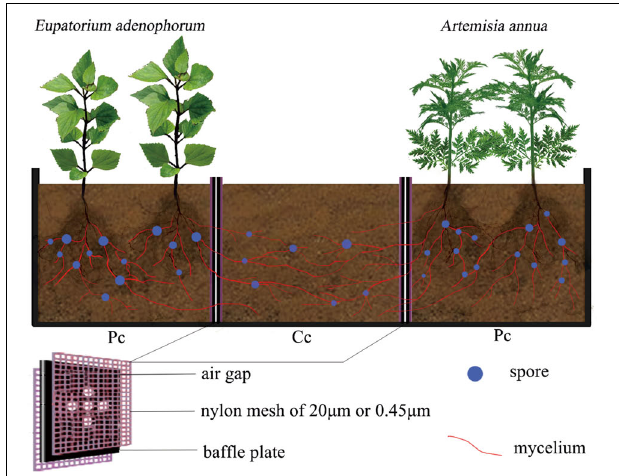
FIGURE 1 | The compartmentalized microcosm growing device. The setup consists of three compartments, two plant compartments on either end, one for the native species and one for the invasive species, and one competition compartment in the center. Plates containing five holes separate the compartments. Depending on the experimental treatment, one of two different meshes line the plates separating the plant compartments from the competition compartment. 20 µ m nylon mesh allows mycelium to pass through but not the plant root system; the 0.45 µ m nylon mesh blocks both mycelium and the plant root system from passing through the baffle plates into the competition compartment. An air gap within the baffle plate, described in more detail in the text, prevents the flow of nutrients between the three compartments. E. adenophorum = invasive plant; Artemisia annua = native plant; Pc = planting compartment; Cc = competition